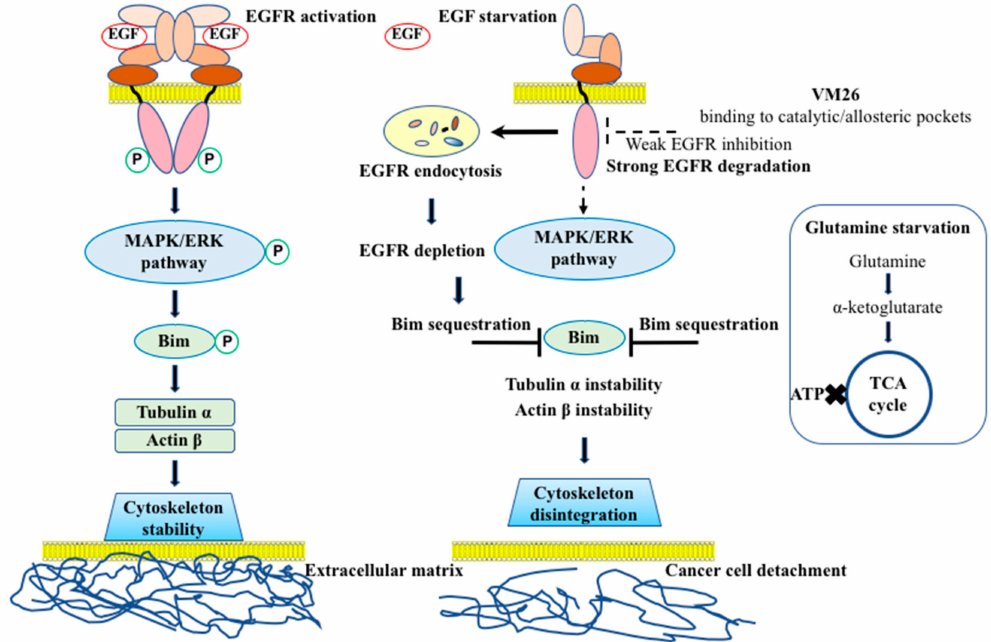
Figure 8. The proposed mechanism of the action of EGFR degraders on cancer cells. The binding of EGF to the extracellular region of the receptor monomers results in rearrangements favorable to the formation of functionally active homodimers that trigger downstream signaling pathways [1]. The compound VM26 binds to the tyrosine kinase catalytic pocket extended into the hydrophobic allosteric site inducing EGFR tra ffi cking and degradation in endosomes (microautophagy). The depletion of EGFR results in Bim sequestration that leads to cytoskeleton disintegration, and ultimately to cancer cell detachment from the extracellular matrix. Glutamine starvation causes the deficiency of α -ketoglutarate and thereby, the inability of cells to replenish the tricarboxylic acid (TCA) cycle and produce ATP. Dual starvation for EGF and glutamine accelerates and reinforces the cytoskeleton disintegration leading ultimately to cancer cell detachment-promoted